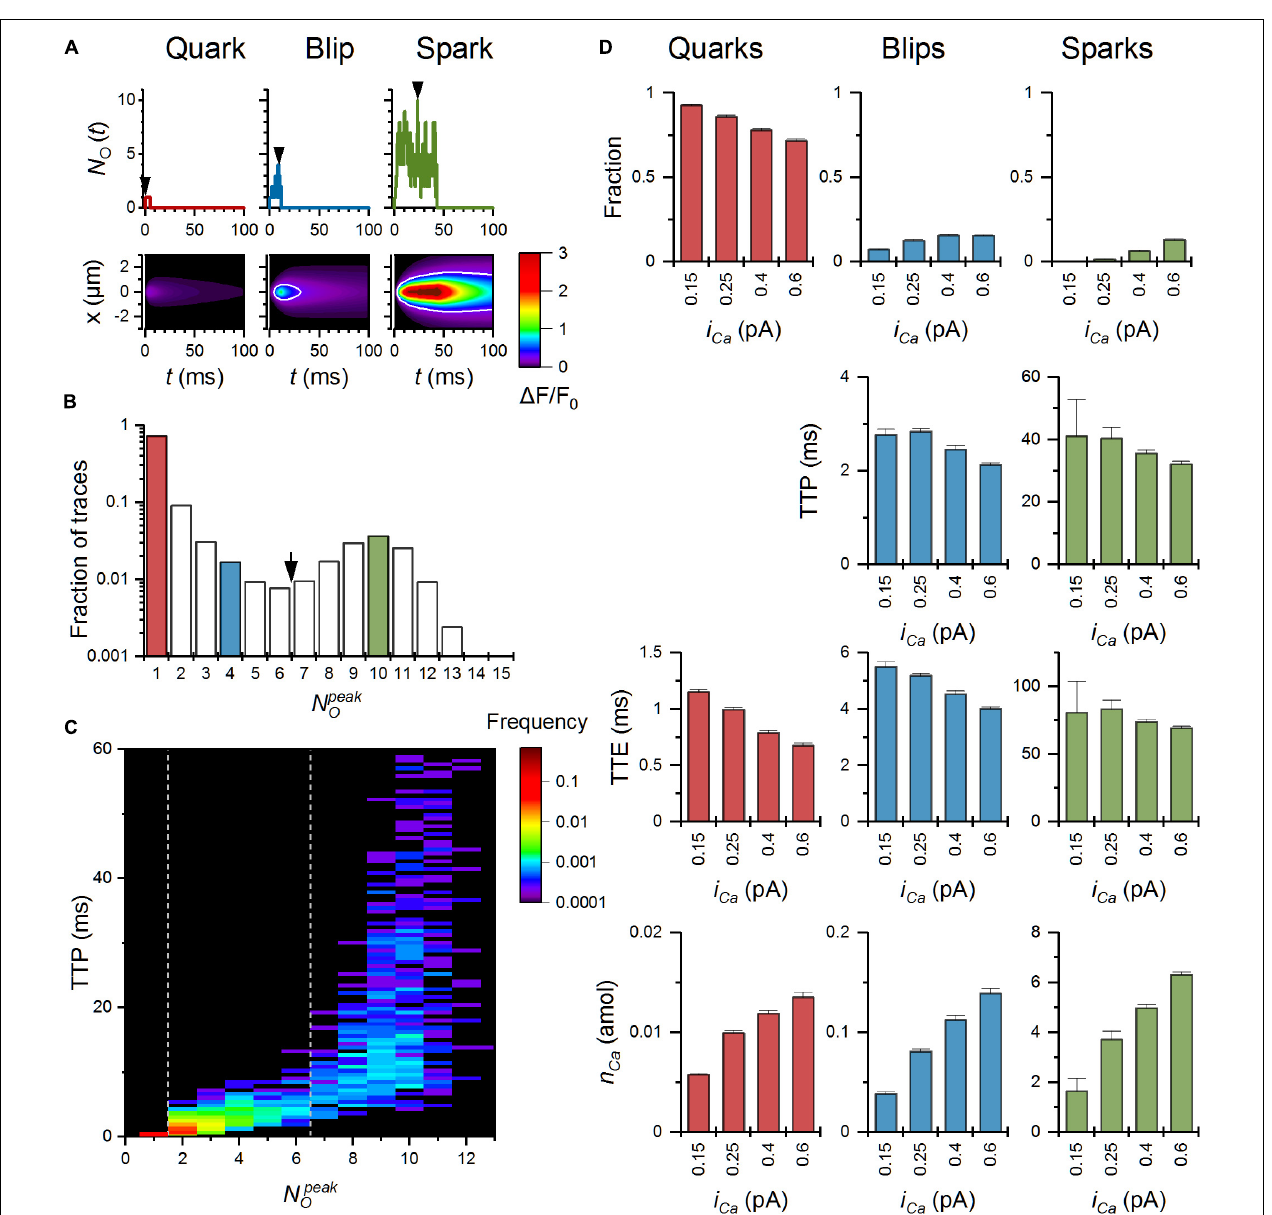
FIGURE 4 | Characteristics of calcium release events (CREs) simulated with the MWC-Ca/Mg RyR model and the reference set of parameters. (A) Top panel – the time courses of simulated CREs representing a typical quark, blip, and spark for i Ca = 0.6 pA; Bottom panel – the fluorescence calcium signals emulating laser line-scan images in a confocal microscope corresponding to CREs in panel (A) . (B) The distribution of the peak number of open RyRs, N peak O , in the simulated calcium release events. The red, blue, and green columns correspond to peaks of respective traces shown in panel (A) . (C) The surface plot of the time to peak vs. N peak O ; dotted lines indicate the N peak O values used for discrimination between quarks, blips, and sparks. (D) Relationships between i Ca values and characteristics of simulated quarks, blips, and sparks; n Ca – the amount of Ca 2 + released per